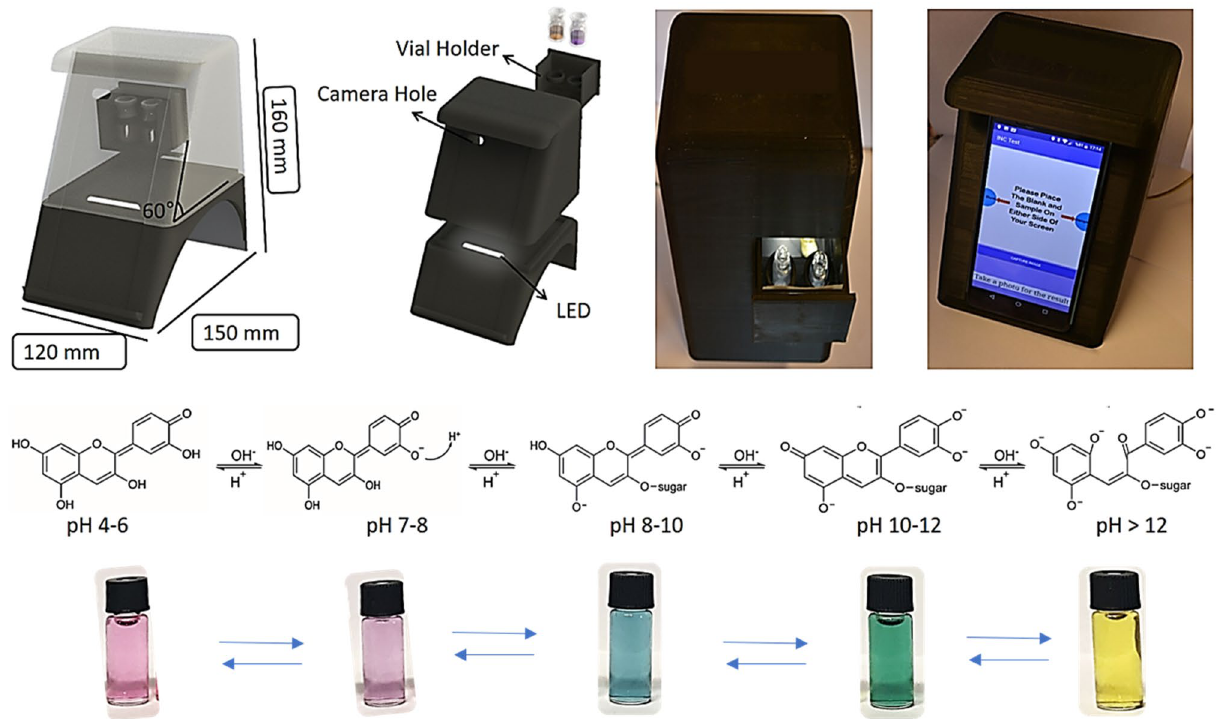
Figure 7. Designing of panel integrated-3D-printed smartphone platform and pH dependent reaction of anthocyanin and color for detection of the pathogens. (SOLIDWORKS Premium 2019 SP4.0 URL link: https:// www. solid works. com/ 3dexp erien ce-